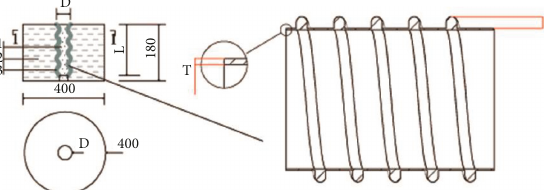
Figure 1: Specimen size and pipe size (mm). 1-Grout, 2-Concrete, 3-Pipe material.